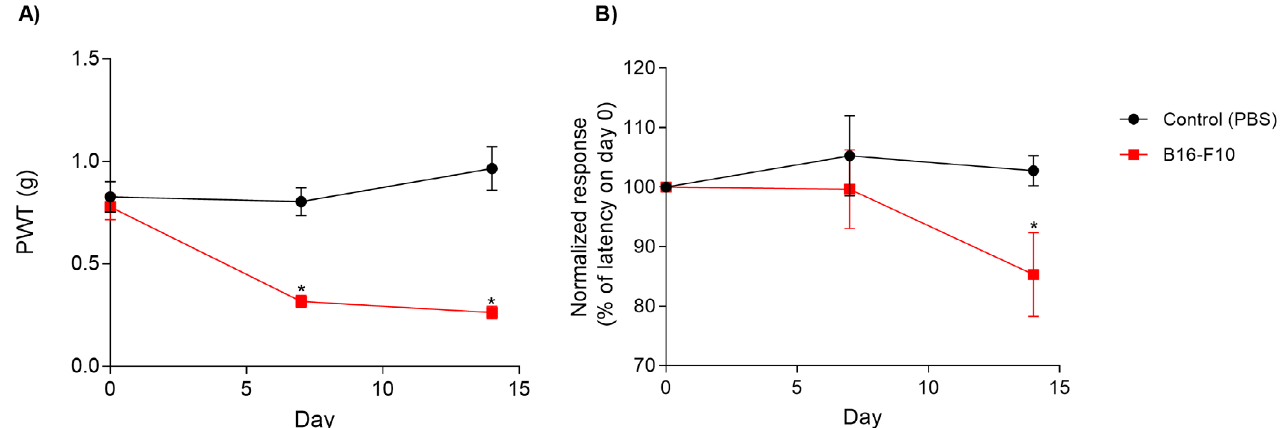
Figure 2. Melanoma cell injection induces mechanical and thermal hyperalgesia. (A) The development of mechanical hyperalgesia. There is a significant reduction in the paw withdraw threshold (PWT) at 7 and 14 days after B16-F10 cell inoculation. (B) Thermal hyperalgesia was seen 14 days after the B16-F10 injection. Both tests have assessed the right hind paw response. *p < 0.05 in comparison with day 0 (ANOVA with repeated measures). Data are expressed as mean ± SEM (n = 12 animals per group).